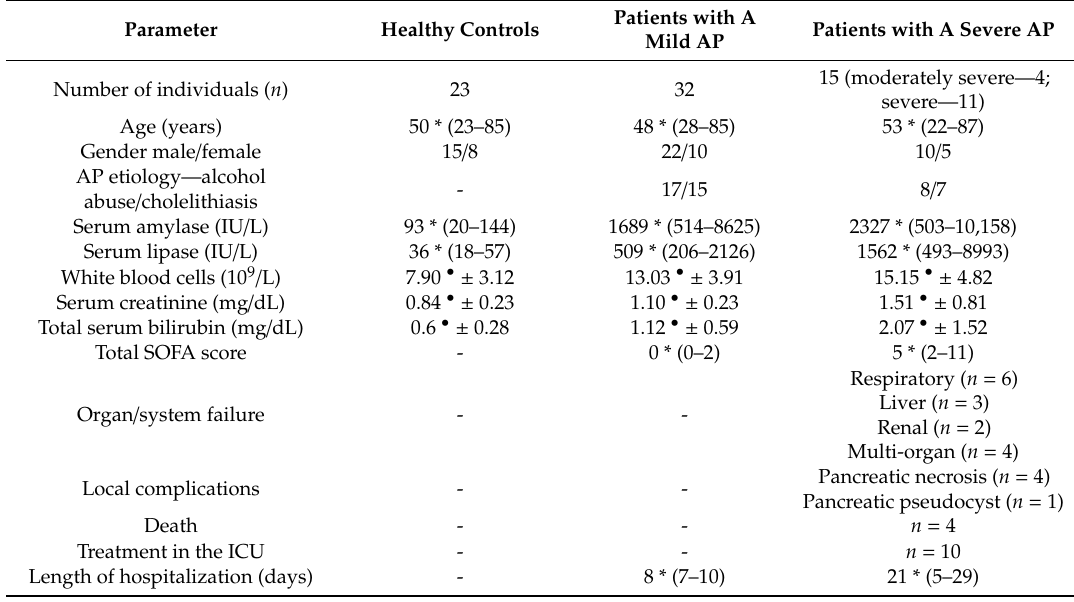
Table 1. Laboratory / clinical characteristic of healthy controls and patients with acute pancreatitis (AP).